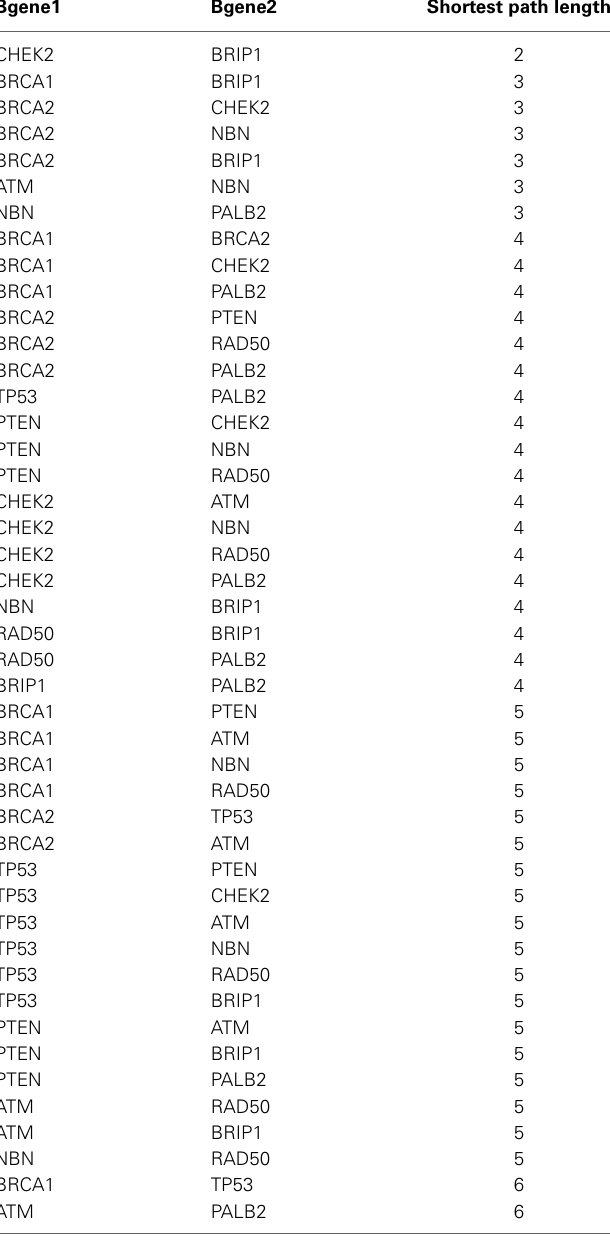
indicate that the sampling distribution is different for each chro- mosome pair because it takes the varying size of the chromosomes into account. For each randomization, e ∈ E , we calculate